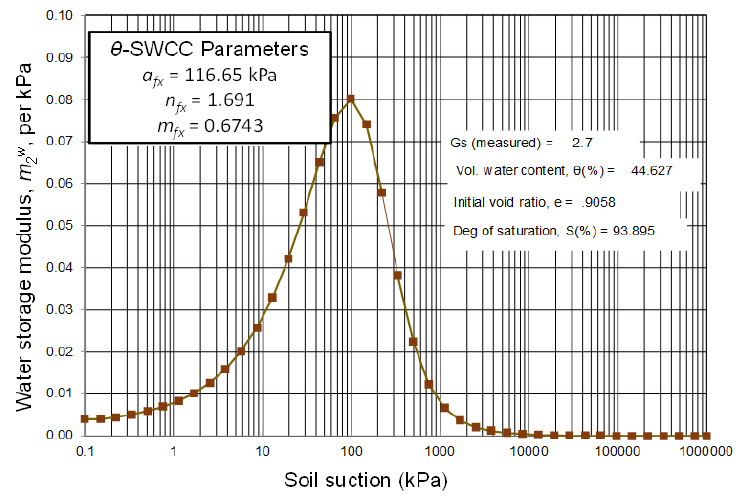
Figure 21. Water storage function versus soil suction.